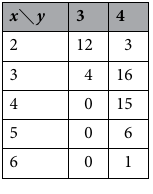
Table 3. a ( x , y ) for P